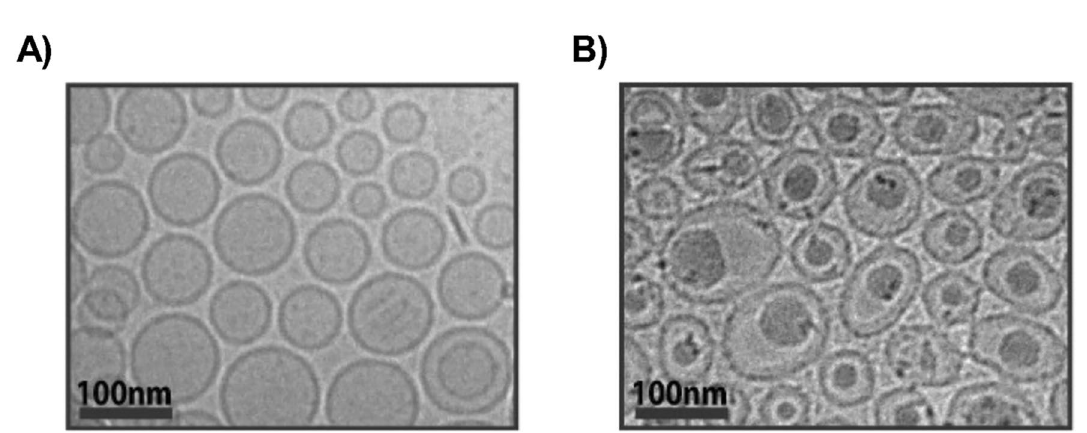
Figure 5. ( A ) In vitro release of NIRB and DOX from NIRB-DOX-FA in bovine serum albumin (BSA) enriched buffer and the ( B ) corresponding encapsulated NIRB:DOX molar ratio. The y-axis shows the mean absolute value (μmoles) of NIRB and DOX remaining in the liposomes (± SD) within collected 100μL fractions when NIRB-DOX-FA liposomes are subjected to biologically relevant (i.e., 50 mg/mL BSA, pH 7.4, 37 °C) sink conditions over five days. Virtually no drug was released between time 0-h and 120-h, resulting in the maintenance of initial versus final NIRB:DOX molar ratios (7.13 ± 0.30:1 at time 0-h and 7.86 ± 1.19:1 at time 120-h). Data is presented as mean ± SD (n = 3).